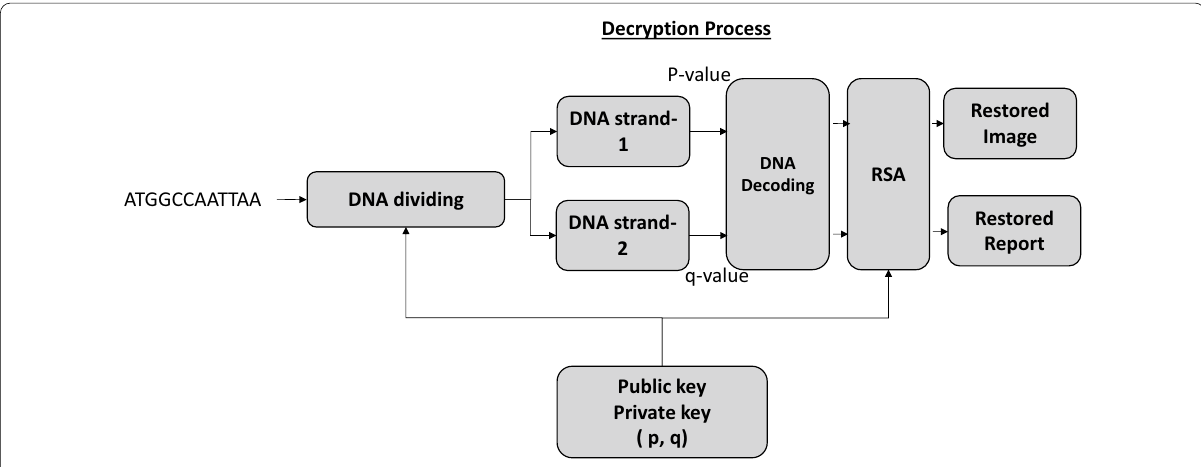
Fig. 2 Decryption process of the proposed cryptographic system